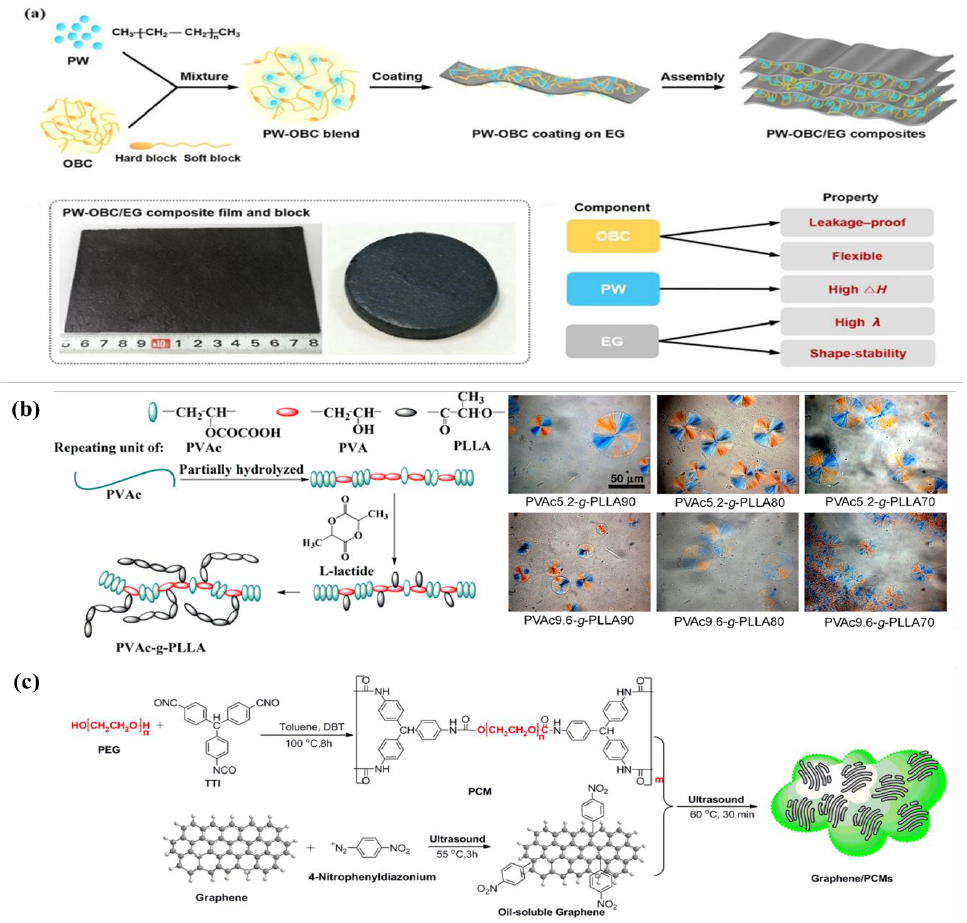
Figure 10. ( a ) PW-OBC/EG composite synthesis and characteristics. ( b ) The PVAc-graft-PLLA copolymer synthesis strategy; microscope pictures taken at 130 °C show melted crystallized copolymer with PLLA contents of 90%, 80%, and 70%. ( c ) Surface-functionalized graphene, PCM, and surface-functionalized graphene/PCM nanocomposites synthesis. Reproduced with permission from [108,111,114].